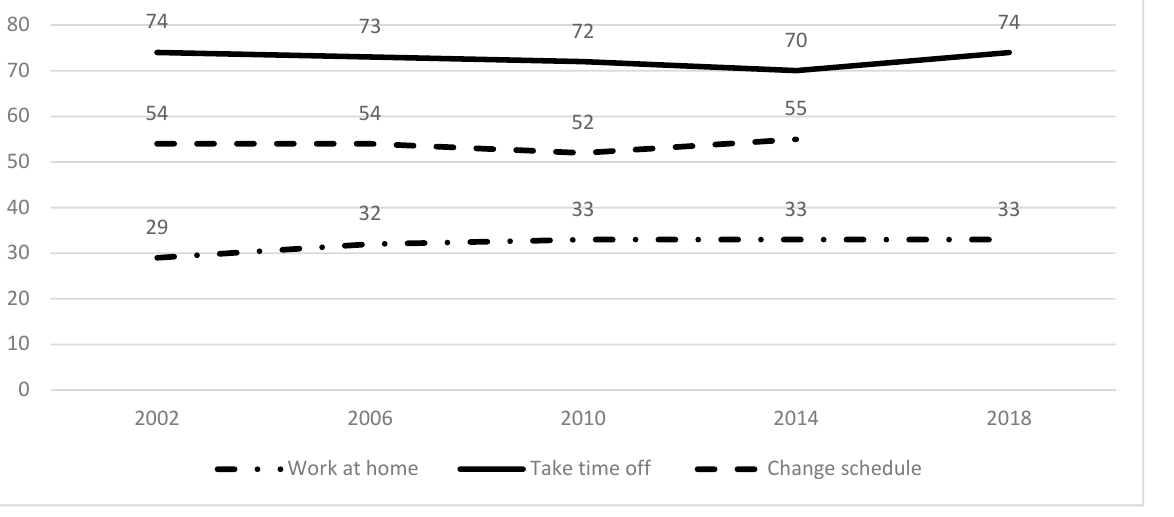
Figure 1. Prevalence of work flexibility over time (%), GSS-QWL data, 2002–2018.